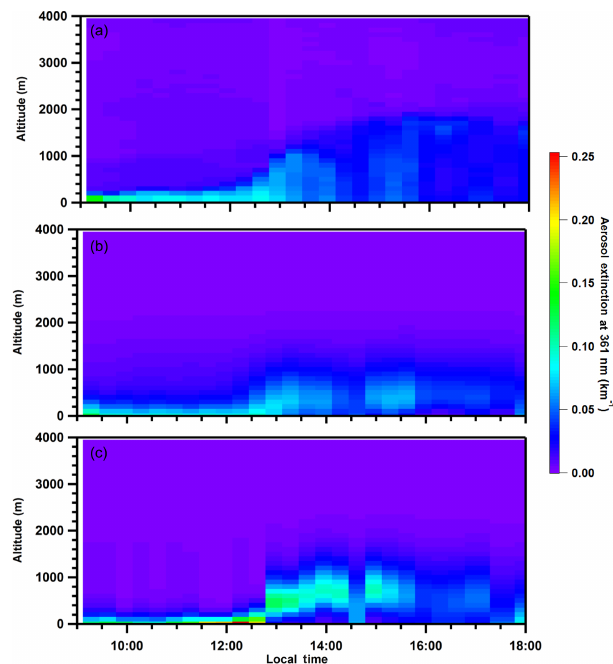
Figure 18. The 7 September vertical profiles of aerosol extinction (361nm) from averaged lidar (a) , smoothed lidar (b) , and MAX- DOAS retrieved measurements (c)